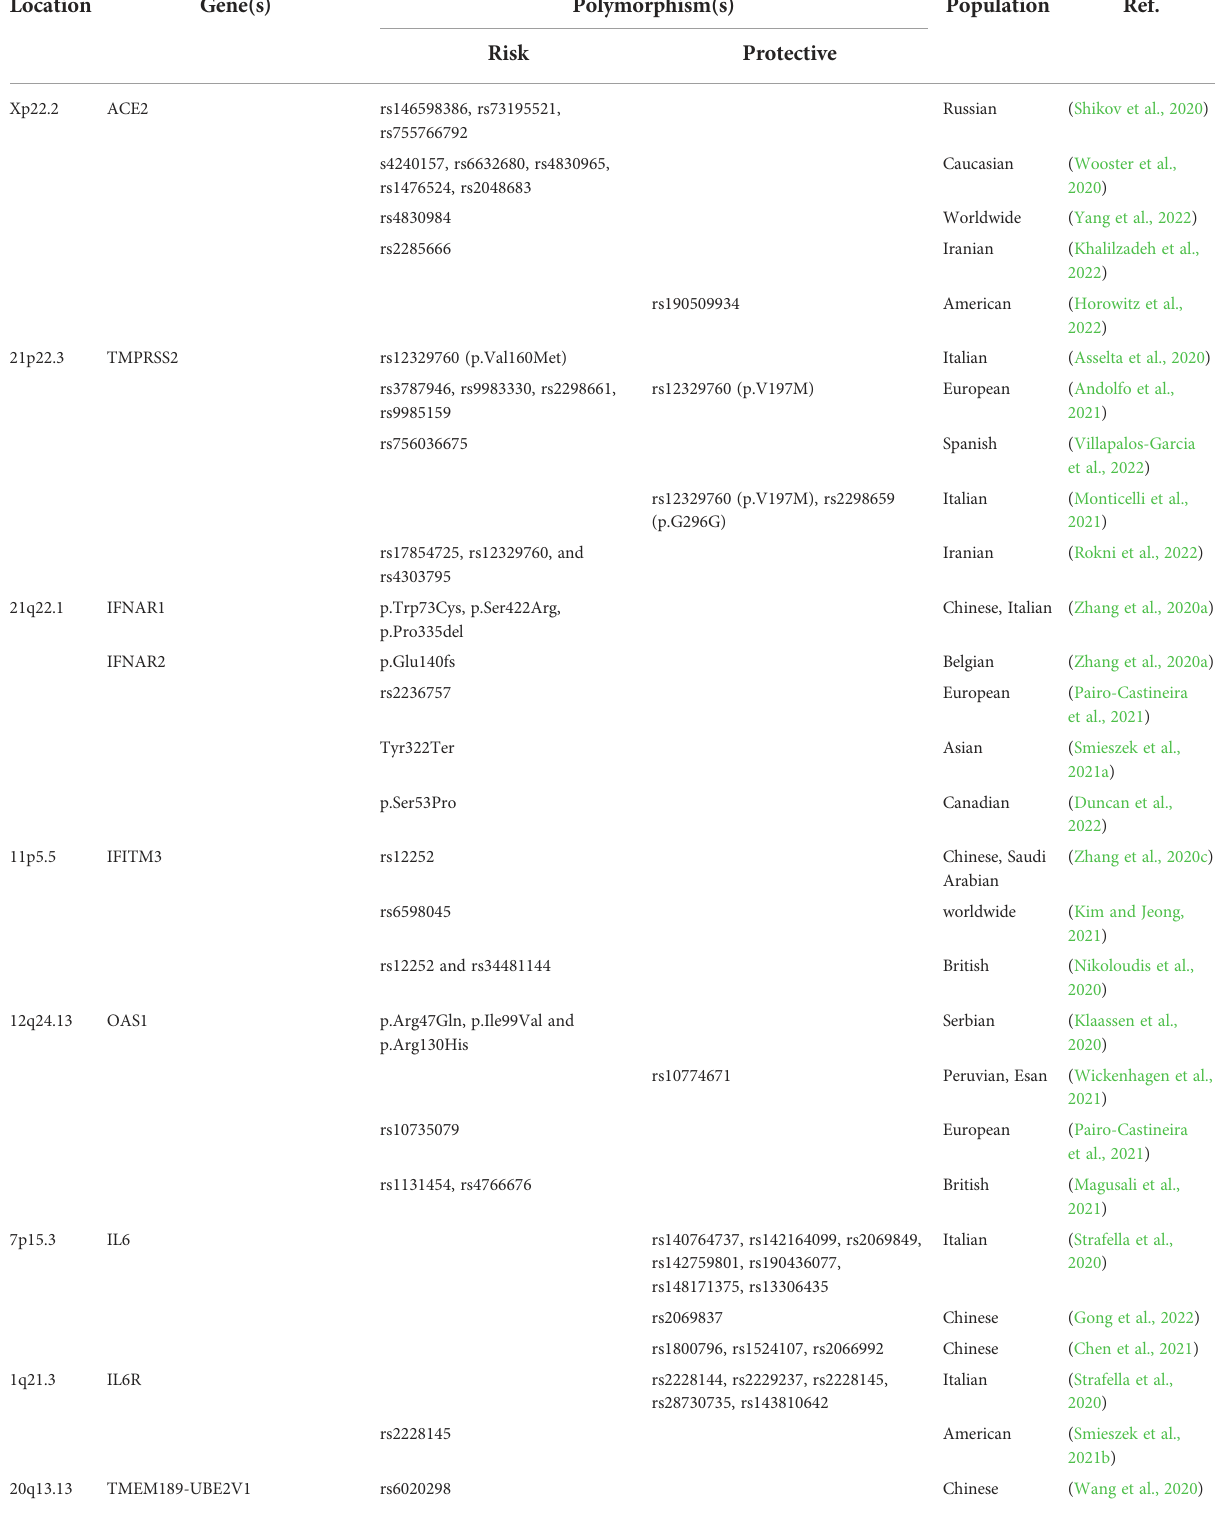
TABLE 1 Summary of genetic variations associated with COVID-19